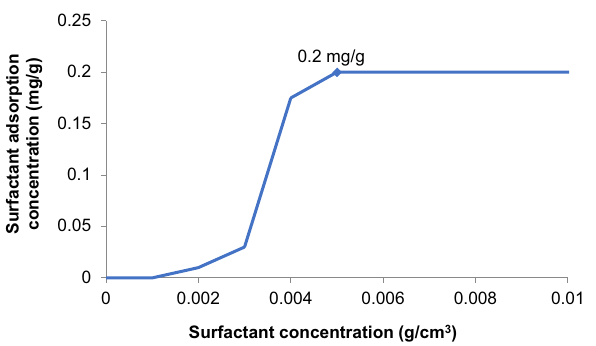
Fig. 7 Oil recovery history matching of test 31